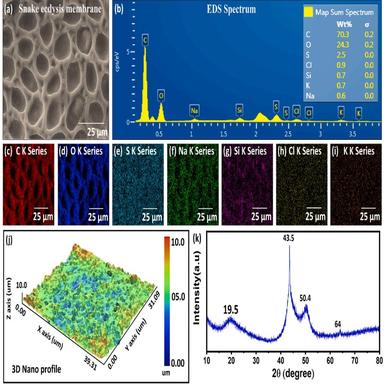
(a) SEM image of snake ecdysis. The EDS spectrum (b) and the elemental analysis of the snake ecdysis such as; (c) C, (d) O, (e) S, (f) Na, (g) Si, (h) Cl, and (i) K series. (j) The 3D nano profile of the snake ecdysis. (k) XRD analysis of the snake ecdysis.